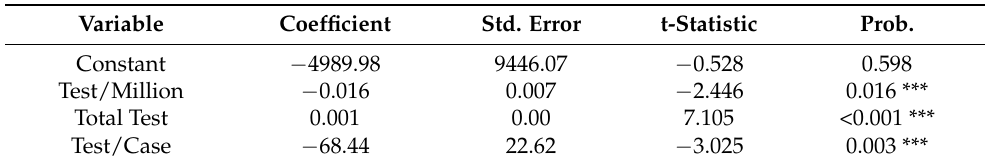
Table 4. Result of OLS regression analysis on factors affecting number of deaths of